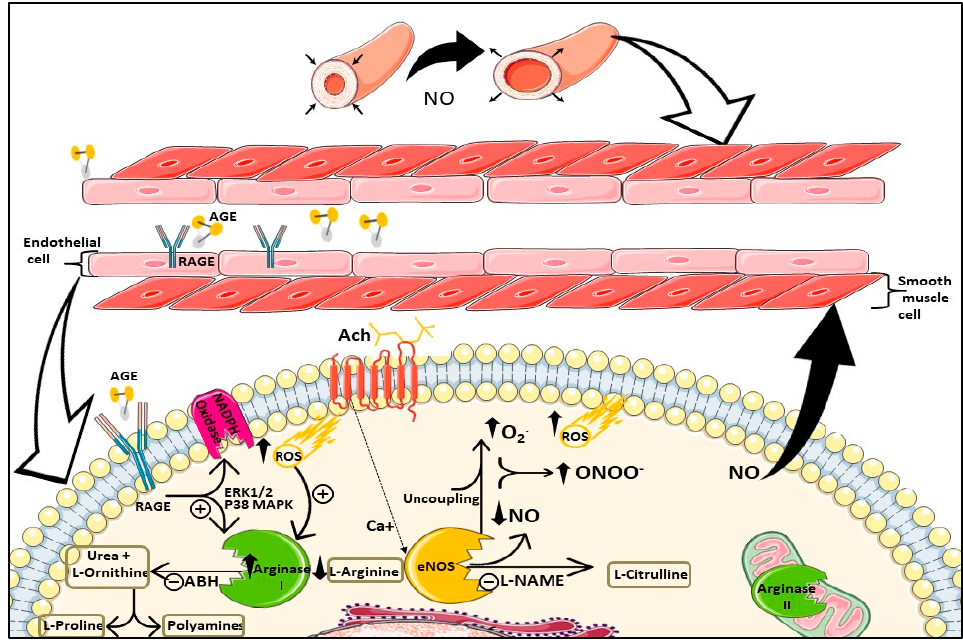
Figure 5. A schematic diagram of AGE/RAGE interaction with arginase enzyme and its effects on endothelial cells and vascular function. Acetylcholine (ACh) stimulates eNOS to produce NO, which is released from endothelial cells to smooth muscle cells, inducing vasorelaxation. Circulating